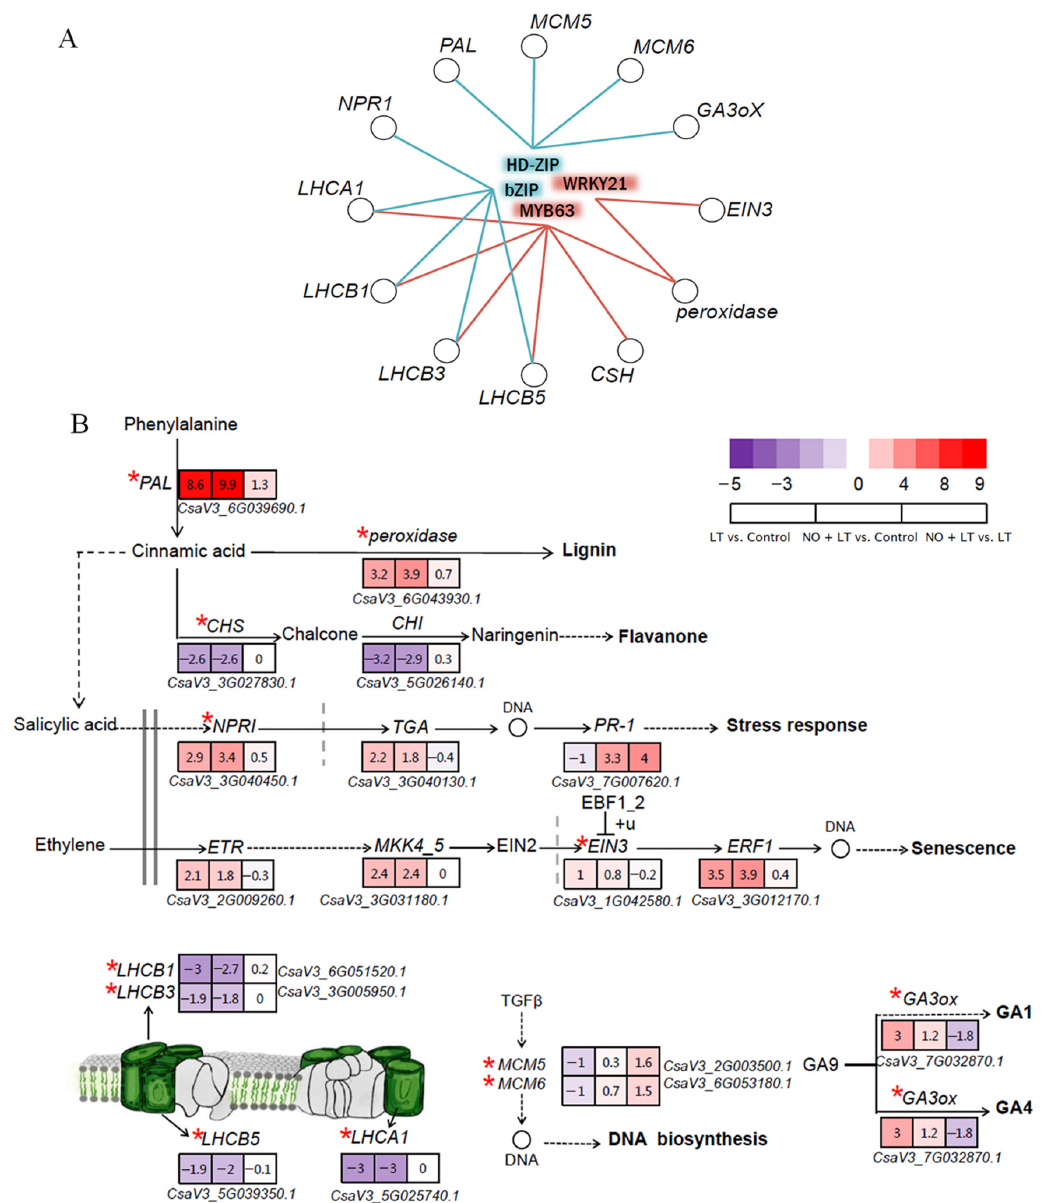
Figure 6. ( A ) A diagram of TFs regulatory network. Blue represents TFs enriched only after NO application under LT stress. Red represents the TFs enriched in both NO and LT. ( B ) Schematic diagram of main pathways and key gene transcript abundance after exogenous application of NO. The Heatmap shows the level of gene expression in different comparisons. The color from red to purple represents the DEGs up-regulated to down-regulated. The gene ID is at the bottom. ‘*’ rep- resents the genes regulated by transcription factors.